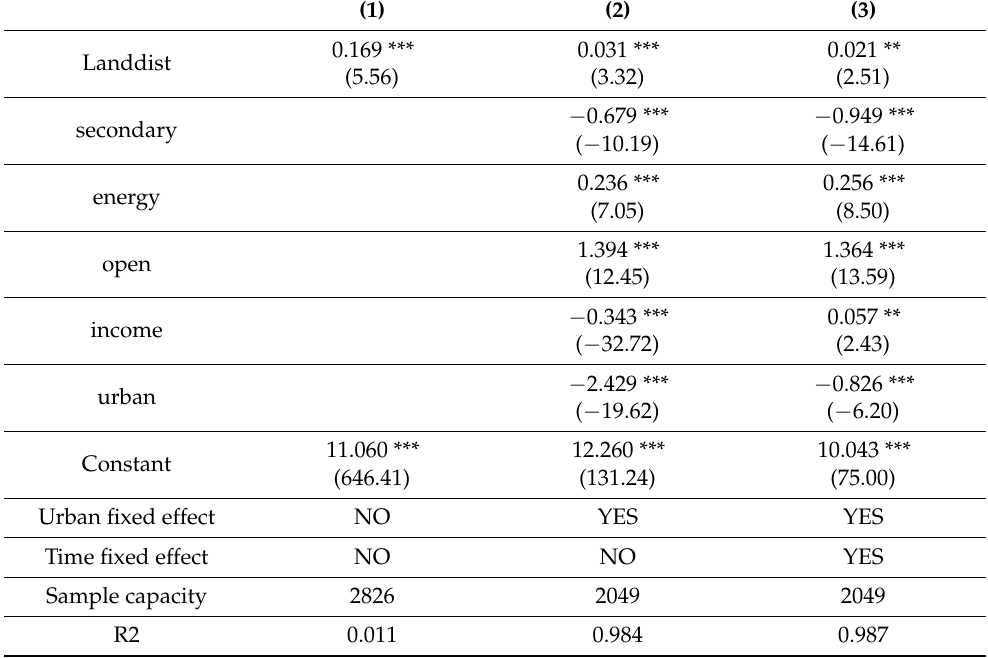
Table 3. Baseline regression